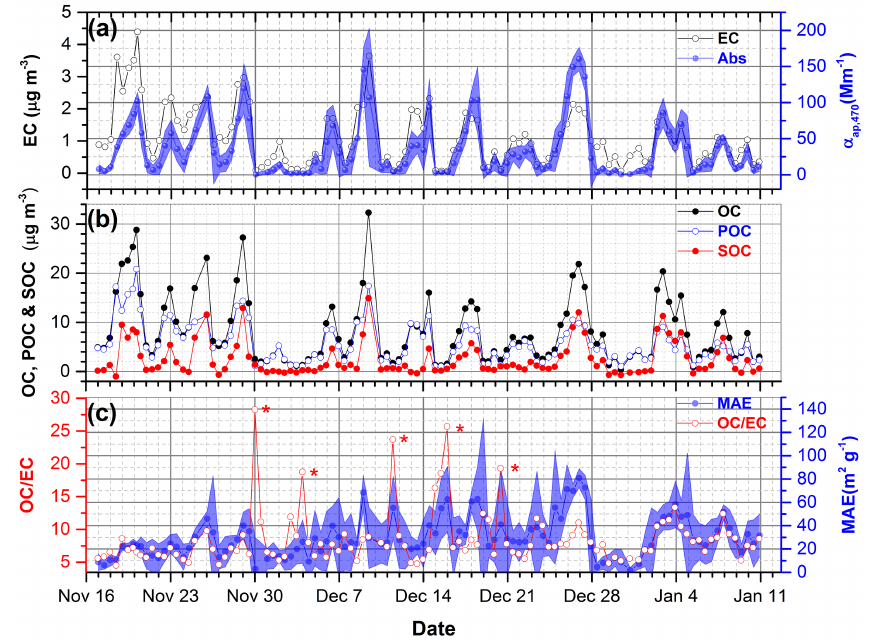
Figure 7. Time series of (a) the measured EC mass concentrations and absorption coefficients at λ = 470nm; (b) the measured OC mass concentrations and the estimated primary OC (POC) and secondary OC (SOC) mass concentrations determined with the EC-tracer method (Lim and Turpin, 2002; Lin et al., 2009; Cheng et al., 2011, the details of the calculation method are given in Sect. S7); and (c) the MAE values of EC and OC to EC ratio (OC/EC). The MAE was calculated by dividing the measured absorption coefficient by the measured concentration of EC. The blue shaded areas indicate the standard deviation. The red stars associated with unusually high values in (c) may arise from artifacts arising from sampling or handling of the